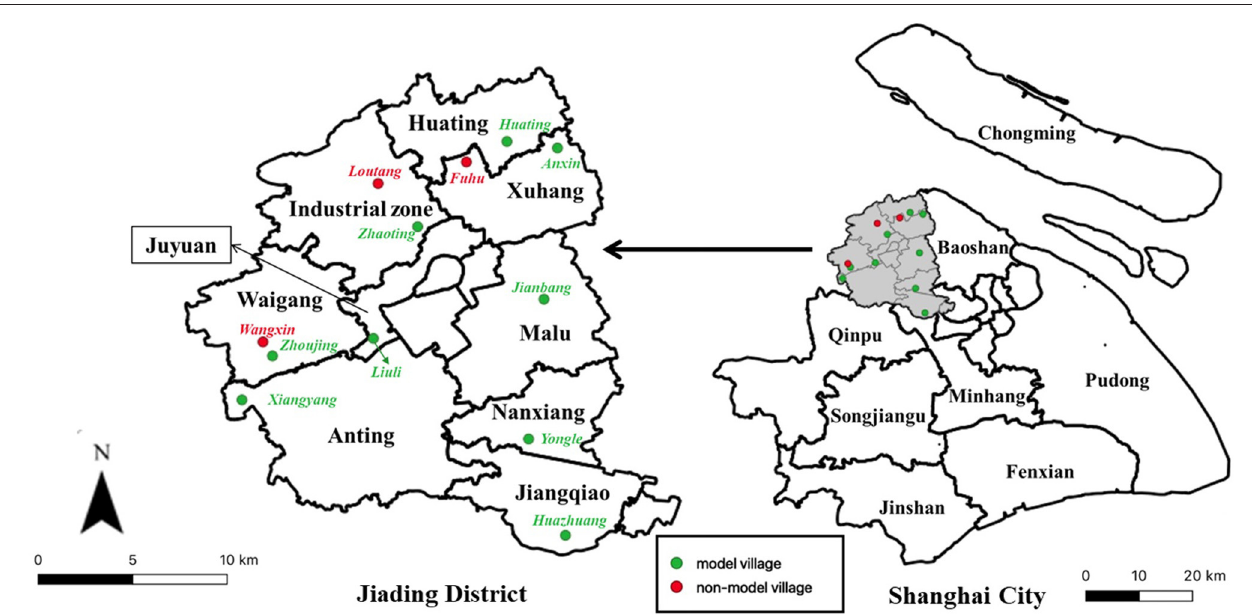
FIGURE 1 | Geographical distribution of the 12 rural villages in Jiading district, Shanghai, selected for enumeration of the rural dog population. (Green markers indicate all nine model villages while red markers indicate the three selected non-model villages. A model village is one in which a set of more stringent dog management regulations was implemented by the